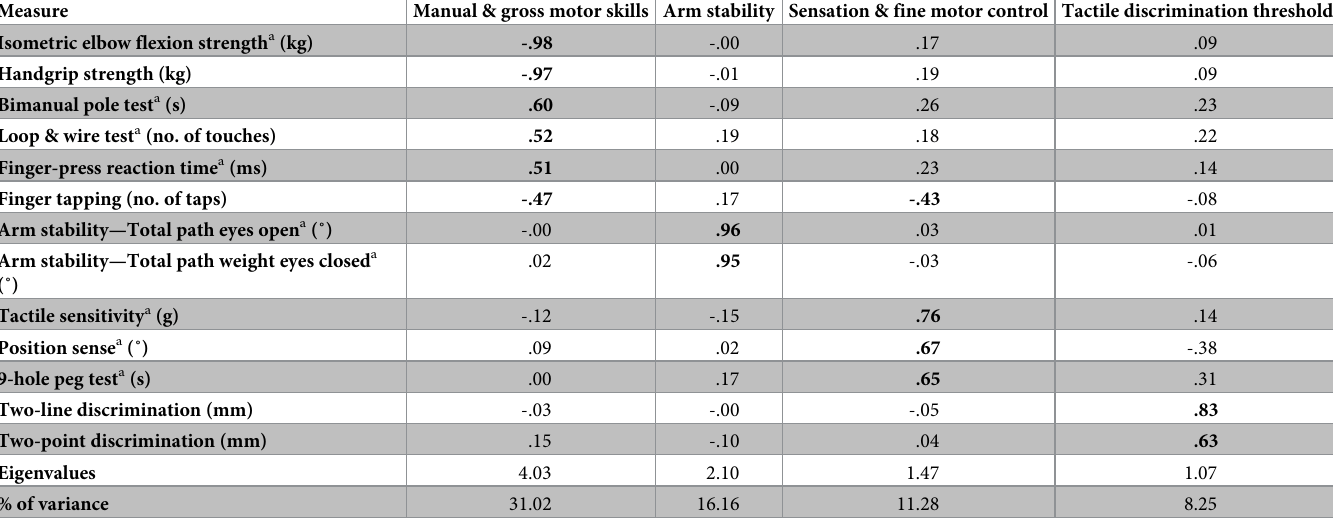
Table 10. Summary of exploratory factor analysis results for the upper limb PPA. Four factors with eigenvalues > 1 were identified and were named ‘manual and gross motor skills,’ ‘arm stability,’ sensation and fine motor control,’ and ‘tactile discrimination thresholds’.